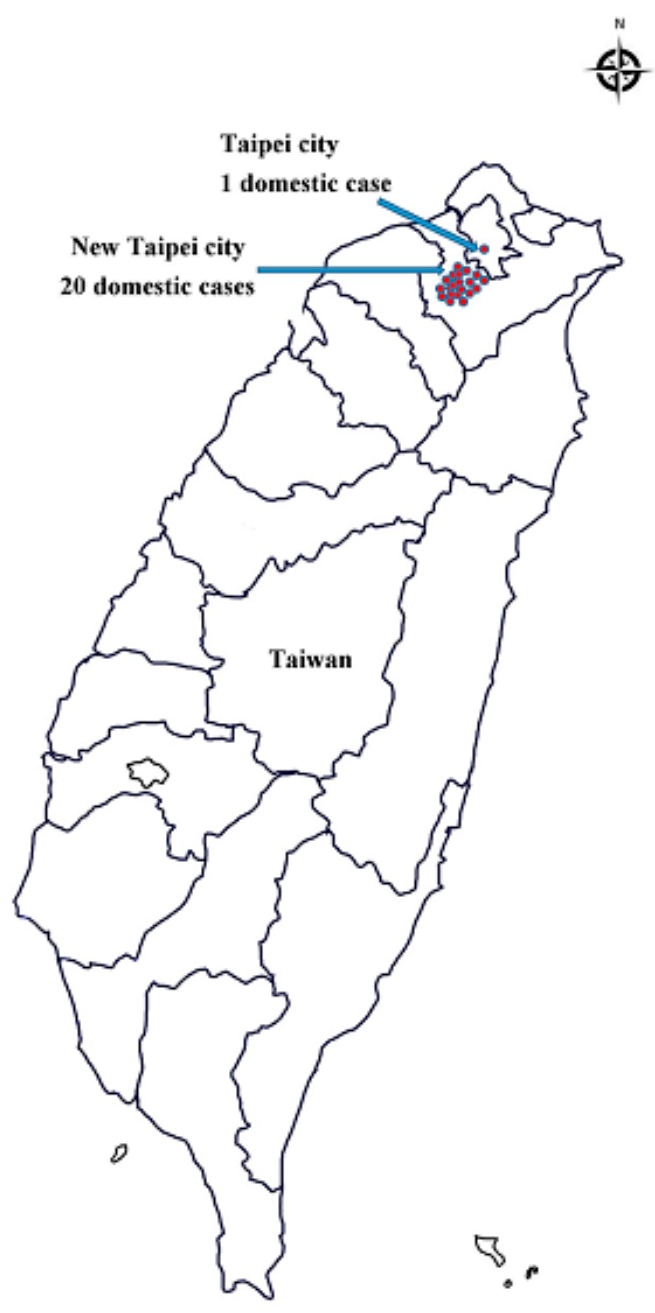
Figure 3. Regional distribution of chikungunya associated with domestic confirmed cases, Taiwan, 2007–2019. Taiwan,